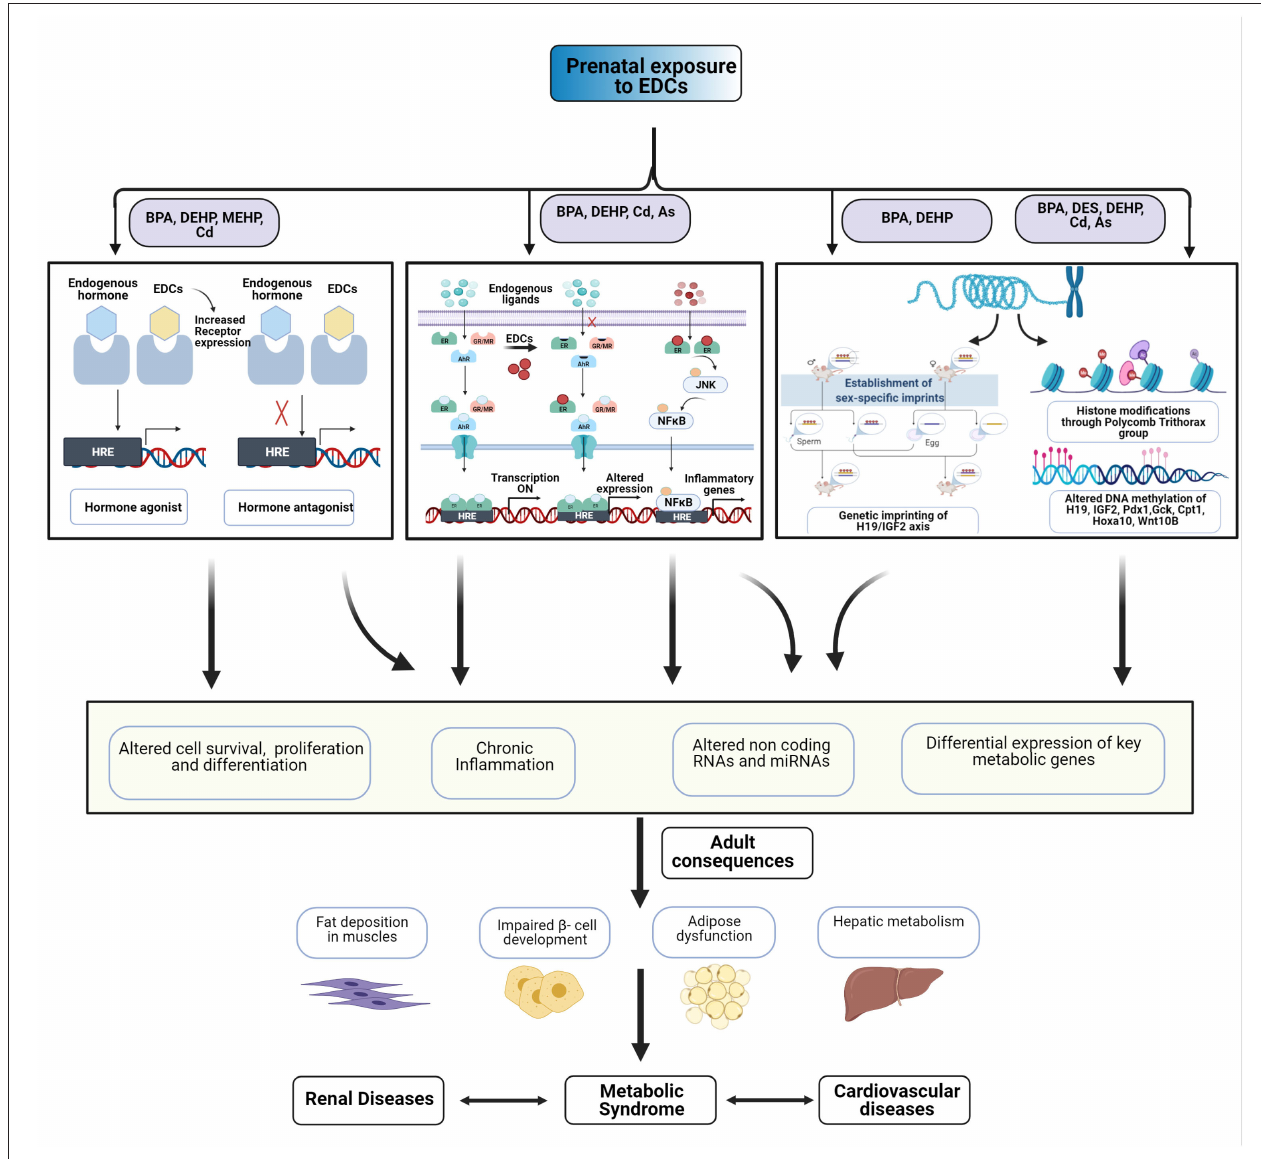
FIGURE 1 | Multiple effects of exposure to endocrine disrupting chemicals (EDCs). EDCs might act through multiple mechanisms to alter cell fate and function. Early-life exposure to EDCs might cause epigenetic dysregulation, pro-inflammatory changes, and changes in energy homeostasis and glucose regulation. These could adversely affect the cardiometabolic renal health of